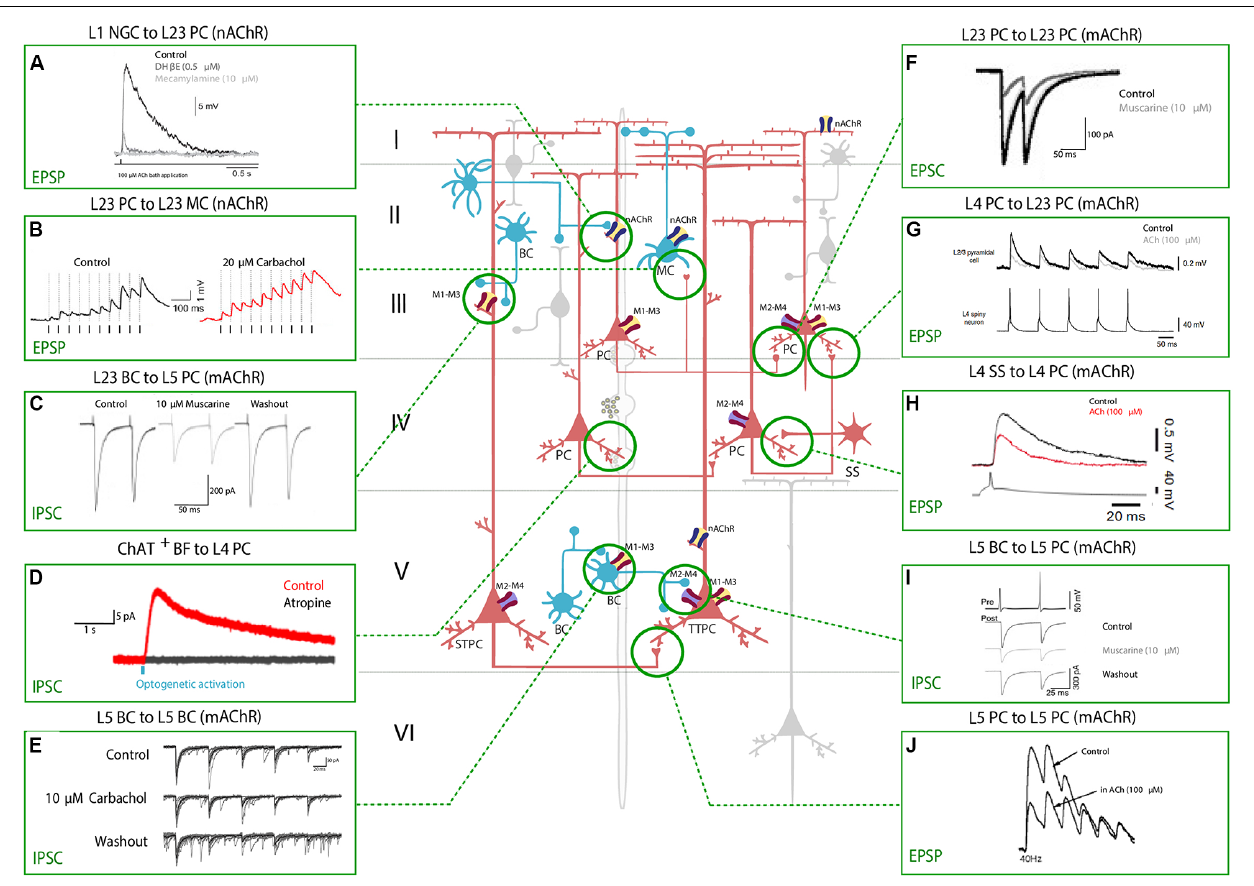
FIGURE 2 | Effect of nAChRs and mAChRs activation on neocortical synaptic dynamics. The central schema represents the main neocortical cell types and their synaptic connections. A fiber of subcortical provenance associated with cholinergic boutons is also shown. Excitatory neurons are shown in red and inhibitory GABAergic neurons are shown in blue. The electrophysiological responses to the application of a cholinergic agonist or antagonist or to basal forebrain (BF) optical stimulation are depicted in the inserts. Panels show the modulation of synaptic dynamics in terms of increase or decrease in PSP/PSC size. Muscarinic and nicotinic cholinergic receptors associated with the observed response, when known, are shown as four main subtypes: M1-M3-M5 like receptors (yellow and red), M2-M4 like receptors (violet and red), α 4 β 2 heteromeric nAChRs (violet and blue) and α 7 homomeric nAChRs (yellow and blue). All shown experimental traces reflect studies listed in Table 3 . Selected traces were recorded in sensory areas of the rodent neocortex. Inclusion criteria for the experimental traces comprise knowledge of the pre and postsynaptic cell-types and the receptor subtype (nicotinic or muscarinic) involved in the response. Abbreviations: PC, pyramidal cell; TTPC, thick tufted pyramidal cell; STPC, slender tufted pyramidal cell; SS, spiny-stellate cell; MC, Martinotti cell; BC, basket cell; NGFC, neurogliaform cell; BPC, bipolar pyramidal cell; IPC, inverted pyramidal cell. Reproduced and adapted from: (left, top to bottom): (A) Brombas et al., 2014; (B) Urban-Ciecko et al., 2018; (C) Kruglikov and Rudy, 2008; (D) Dasgupta et al., 2018; (E) Yamamoto et al., 2010; (F) Salgado et al., 2007; (G,H) Eggermann and Feldmeyer, 2009; (I) Kruglikov and Rudy, 2008; (J) Markram et al., 1997. For more exhaustive information on technique, species and cortical area examined, see Table 3